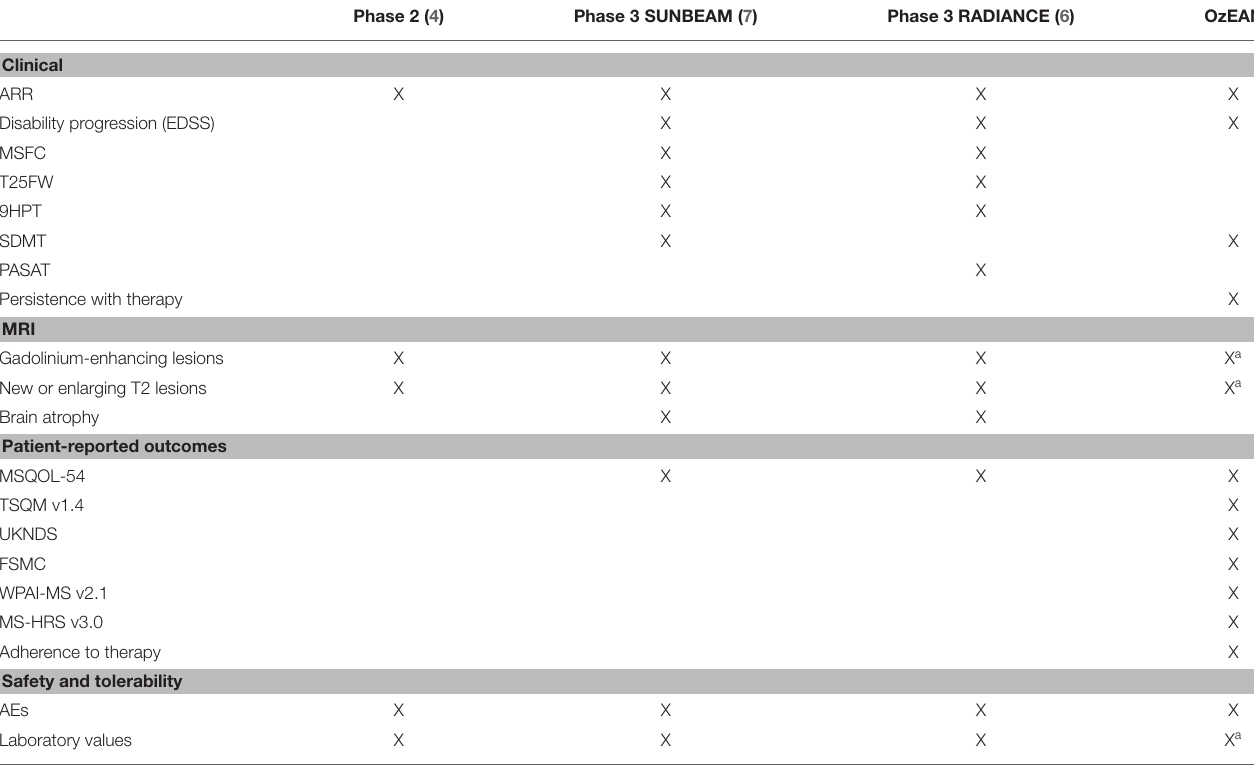
TABLE 5 | Outcome measures in OzEAN compared with phase 2 and phase 3 studies of